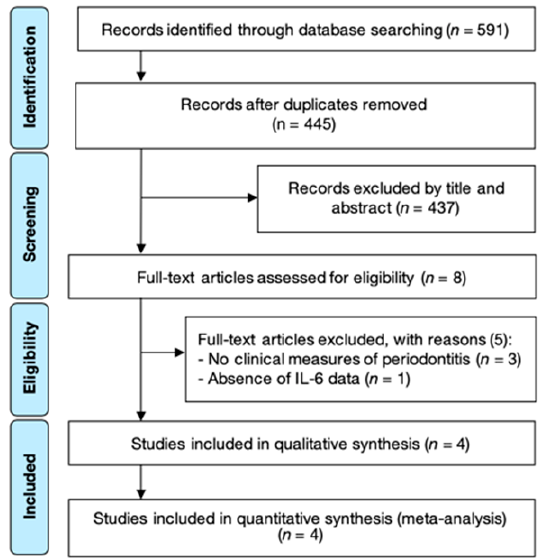
Figure 1. PRISMA flow-chart representing the results of the workflow to identify eligible studies.